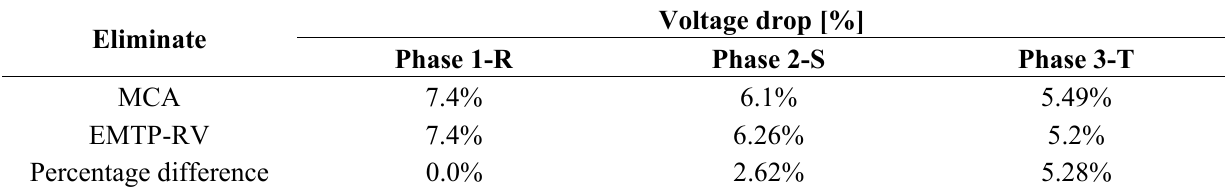
Table 2. Single circuit OHL voltage drop comparison.